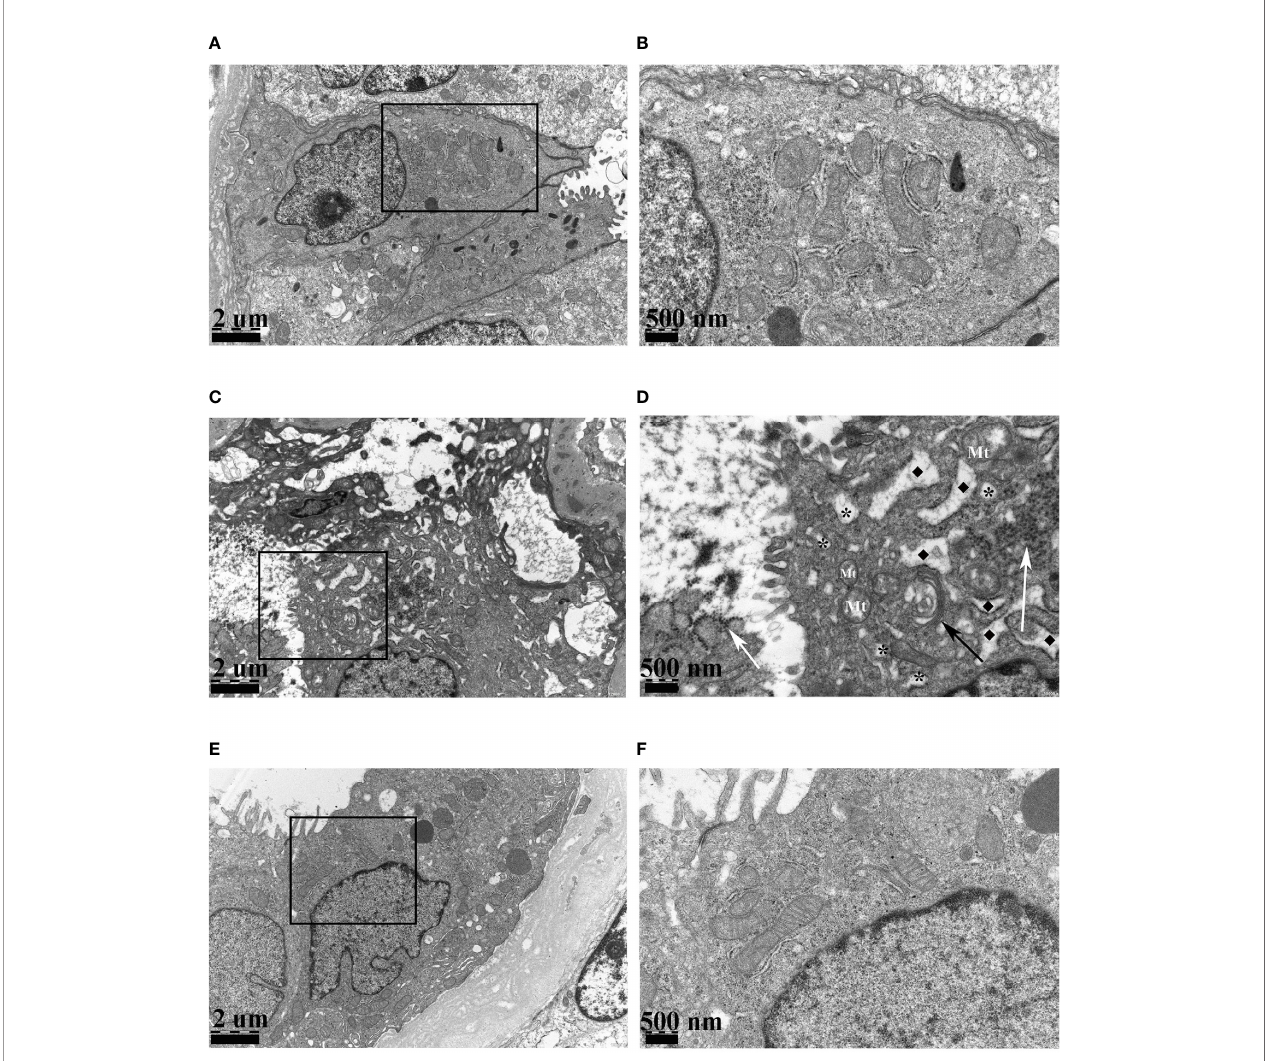
FIGURE 2 | The electron micrographs of stable transplanted recipient (A, B) , BKPyVAN recipient 2 (C, D) , and resolved BKPyVAN (E, F) . The fi gures of the high- power fi eld on the right (B, D, F) corresponded to the fi gures in the box of the low-power fi eld on the left (A, C, E) . The mild swelling of mitochondrion (Mt) and Golgi apparatus (black arrow), numerous virus particles (white arrows), cytoplasmic vacuolar degeneration (*), and expansion of rough endoplasmic reticulum ( ◆ ) can be observed in BKPyVAN. (A, C, E) × 12,000, (B, D, F) ×